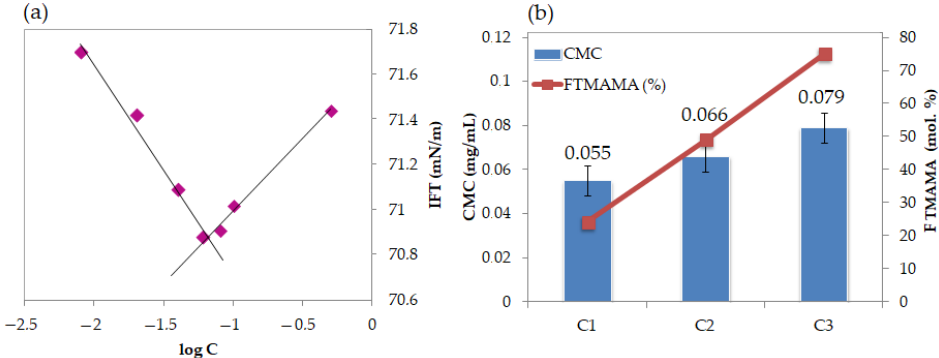
solution at 25 ◦ C; ( b ) influence of polymer chain length on critical micelle concentration (CMC)